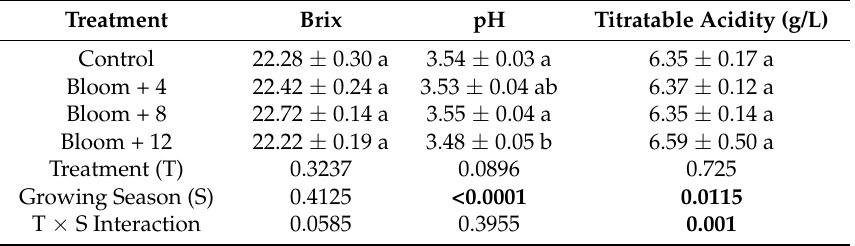
Table 3. Two-way analysis of variance (ANOVA) with interaction showing mean values and p -values of fruit composition parameters at harvest by cluster thinning treatment. Combined two-year averages followed by standard error of the mean. Also shown are p -values corresponding to main effects and the interaction between treatments and growing season ( n = 3). Different letters within a column indicate significant differences between treatment groups for Fisher’s LSD at p < 0.05. p values below 0.05 are shown in bold